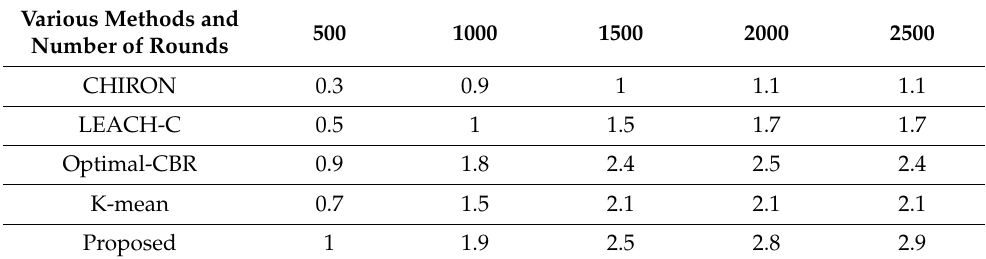
Table 5. Differentiation of throughput in several methods.